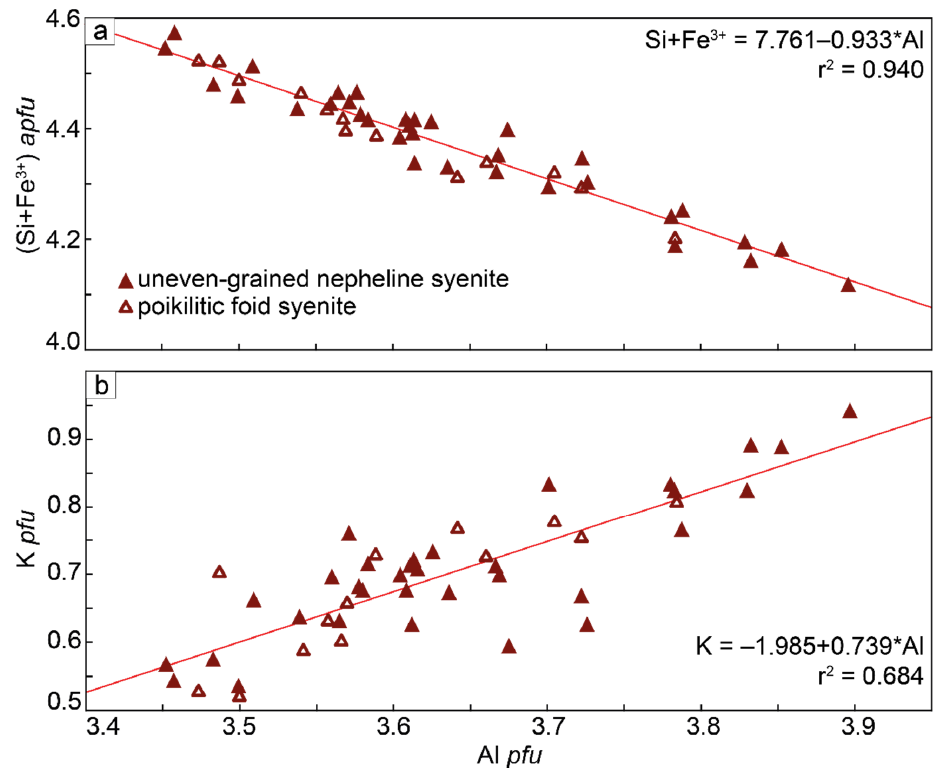
Figure 10. ( a ) Binary diagram showing the summary concentration (Si + Fe 3+ ) in nepheline from poikilitic rocks as function of Al content; ( b ) binary diagram showing the K concentration in nepheline from poikilitic rocks as function of Al content.